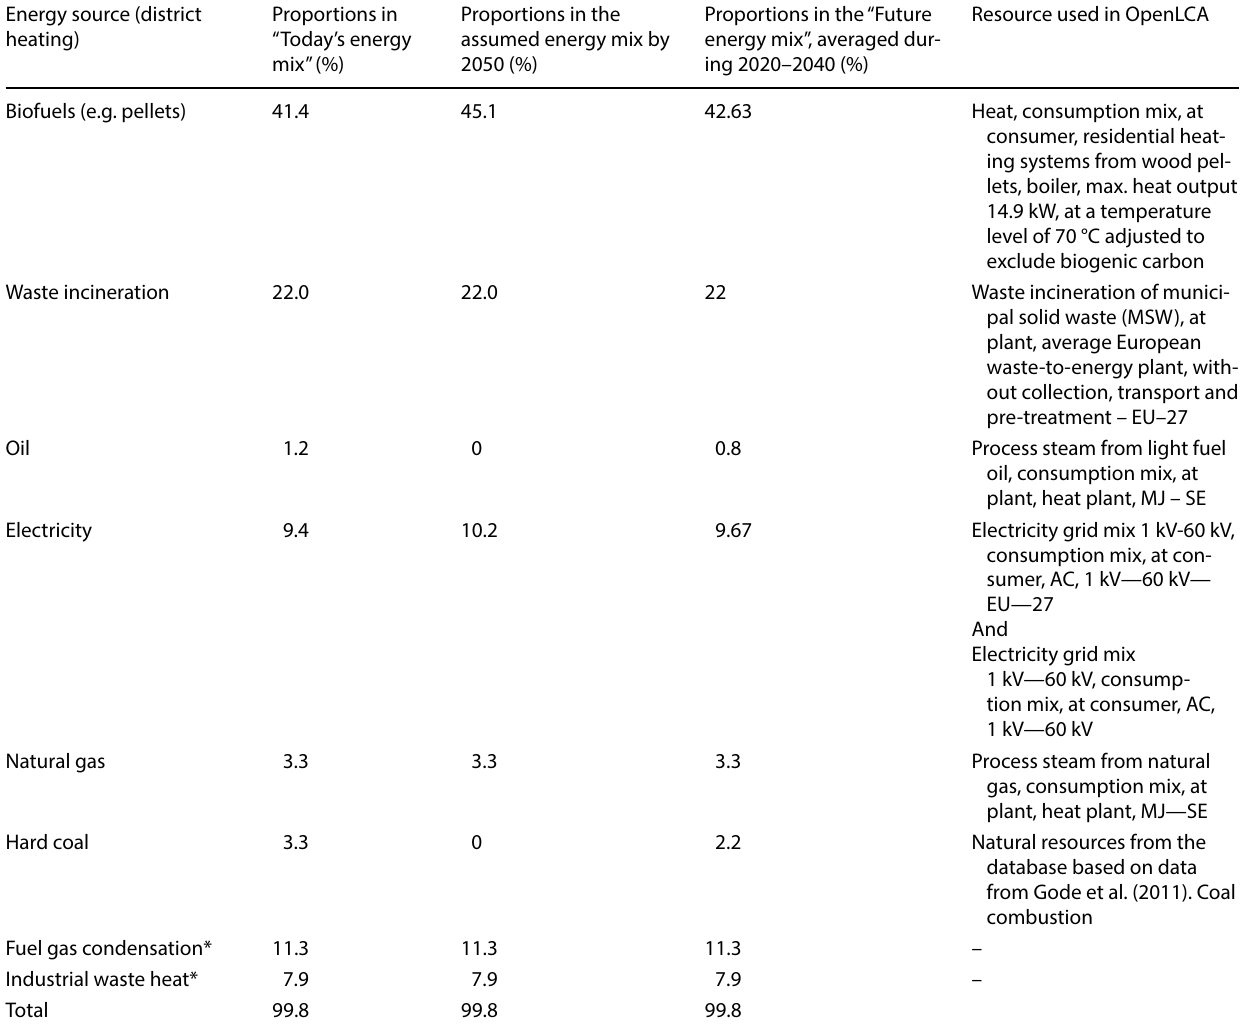
Table 2 Proportions of different energy sources considered in this study. *allocated to the main production